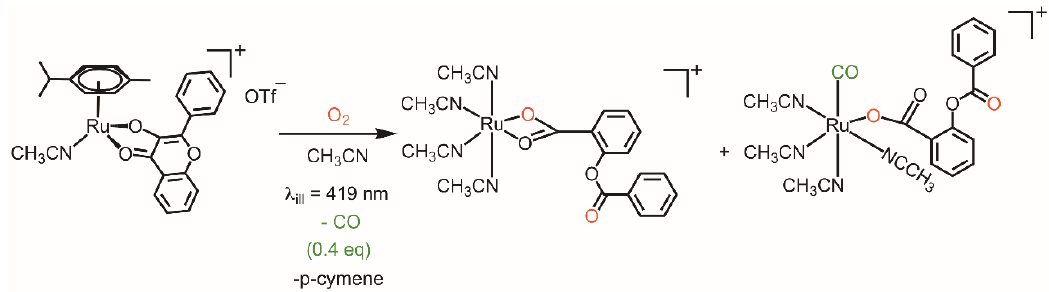
Scheme 17. Reactivity of Ru II 3-hydroxyflavonolato complex with O 2 upon illuination with visible light (λ ill = 419 nm)